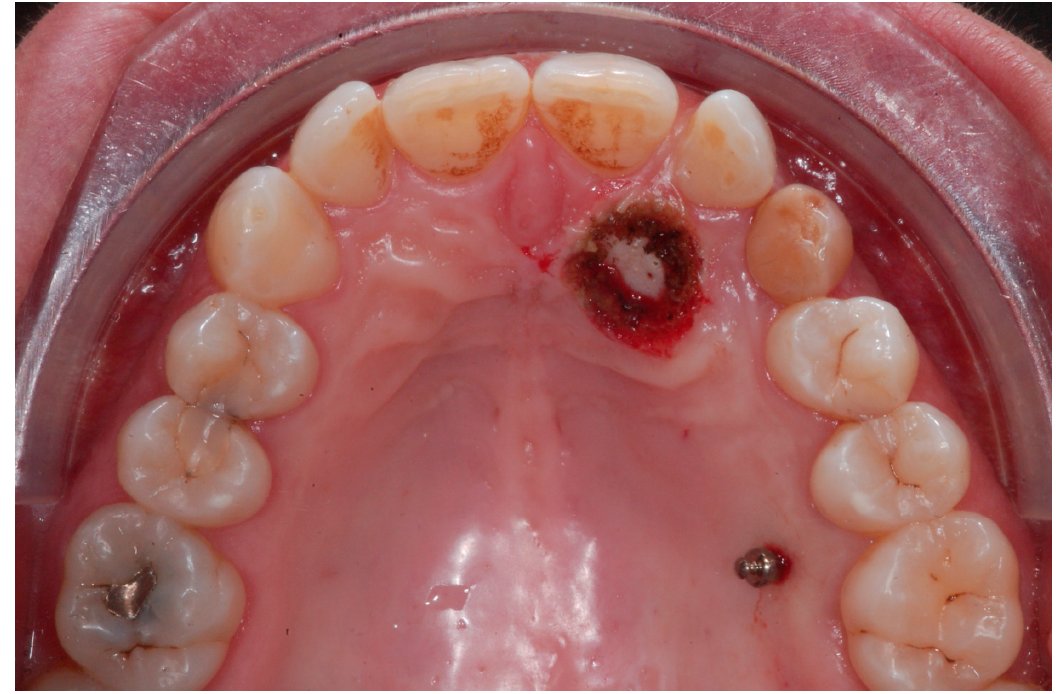
Figure 11. Mini-invasive laser gingivectomy.